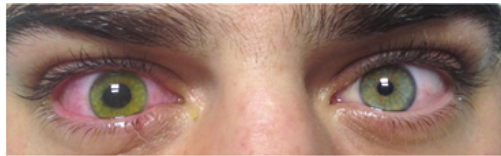
Figure 1: Patient’s photo showing irregular and dilated pupil of the treated right eye at the end of the CXL procedure (anisocoria).